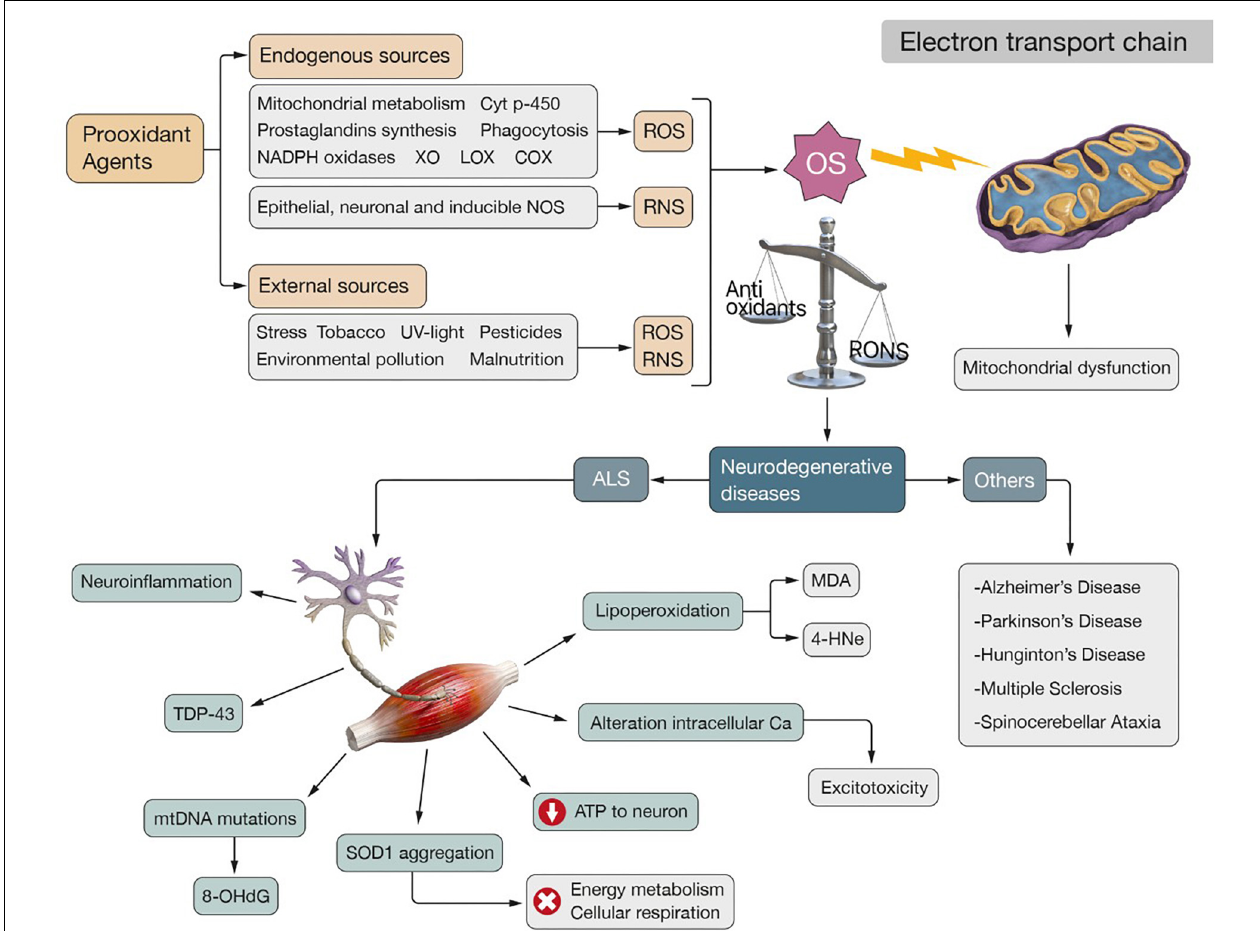
FIGURE 1 | Physiopathogenesis of ALS. Oxidative stress is caused by an imbalance between antioxidant defenses and RONS in favor of these second ones. The endogenous production of ROS is secondary to different prooxidant agents: mitochondrial and cytochrome p-450 metabolism, prostaglandins synthesis, phagocytosis, NADPH oxidases, XO, LOX and COX. Among the endogenous sources of RNS it should be noted the activity of epithelial, neuronal and inducible NOS. Exogenous sources also can produce RONS: stress, tobacco, UV-light, pesticides, environmental pollution and malnutrition. OS affects the normal functioning of the ETC, producing mitochondrial dysfunction that generates more ROS, which leads to a “vicious-cycle” that increases metabolic stress. This situation characterizes neurodegenerative diseases such as: ALS, AD, PD, MS, HD, and SA. In the case of ALS, OS and mitochondrial dysfunction have been identified as two mechanisms involved in its pathogenesis. They are related to neuroinflammation, aggregation of TDP-43, mutations in the mtDNA that produce characteristic OS biomarkers such as 8-OHdG, aggregation of SOD1 which impairs energy metabolism and cellular respiration, affectation of ATP supply to neurons and disturbance of the intracellular calcium homeostasis that results in excitotoxicity. The formation of highly reactive end products such as MDA and 4-HNE, both secondary to the lipoperoxidation of the neuronal membranes, is also